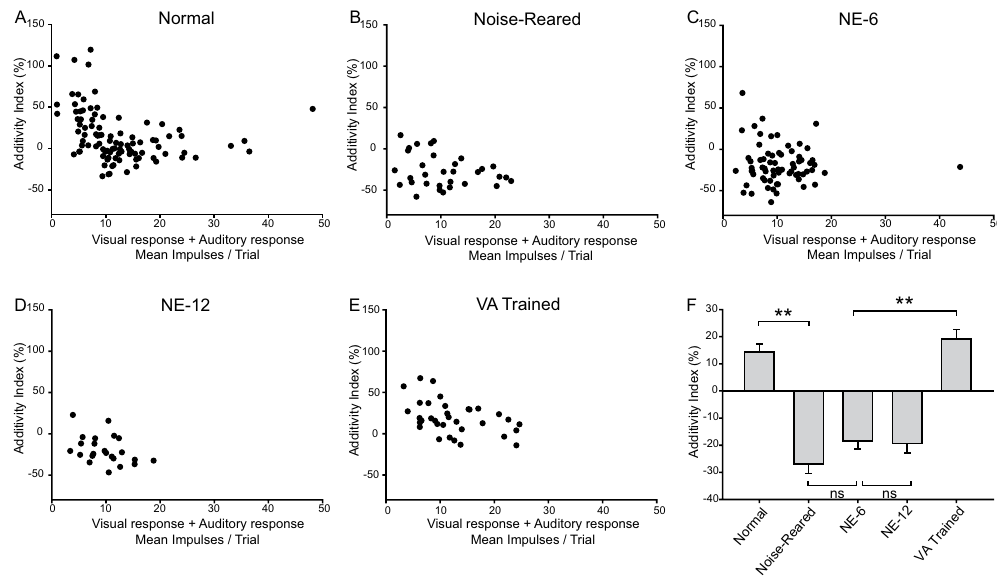
Figure 6. The Additivity Index reveals that the persistence of the multisensory integration deficit induced by noise-rearing is reversed by cross-modal (VA) training. This index uses the sum of the comparator unisensory responses as a benchmark with which to evaluate multisensory integration. Note the difference between the normal scatter plot ( A ) (each point represents a single neuron) and those after noise-rearing ( B ), and after 6 and 12 months of housing in a normal environment ( C , D ). Only after cross-modal training does the scatter plot approximate that seen in the normal animal ( E